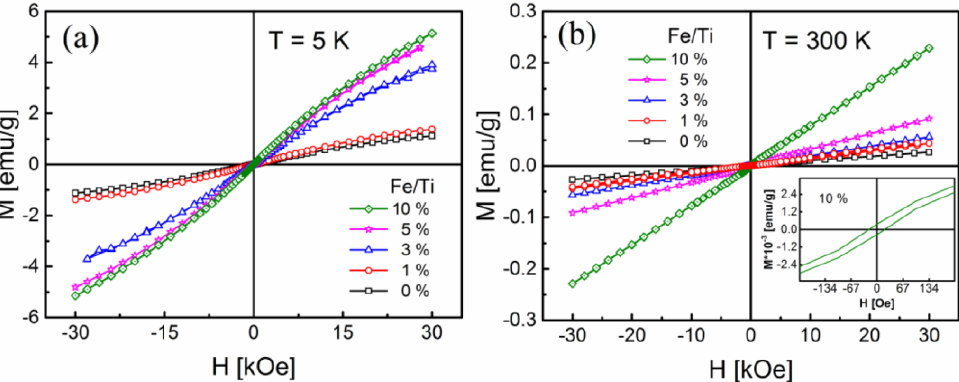
Figure 13. Magnetization (M-H) curves for iron-doped TiO 2 nanoparticles compared to pure TiO 2 measured under an external magnetic field (H), from −30 to 30 kOe at temperatures of ( a ) 5 K and ( b ) 300 K.